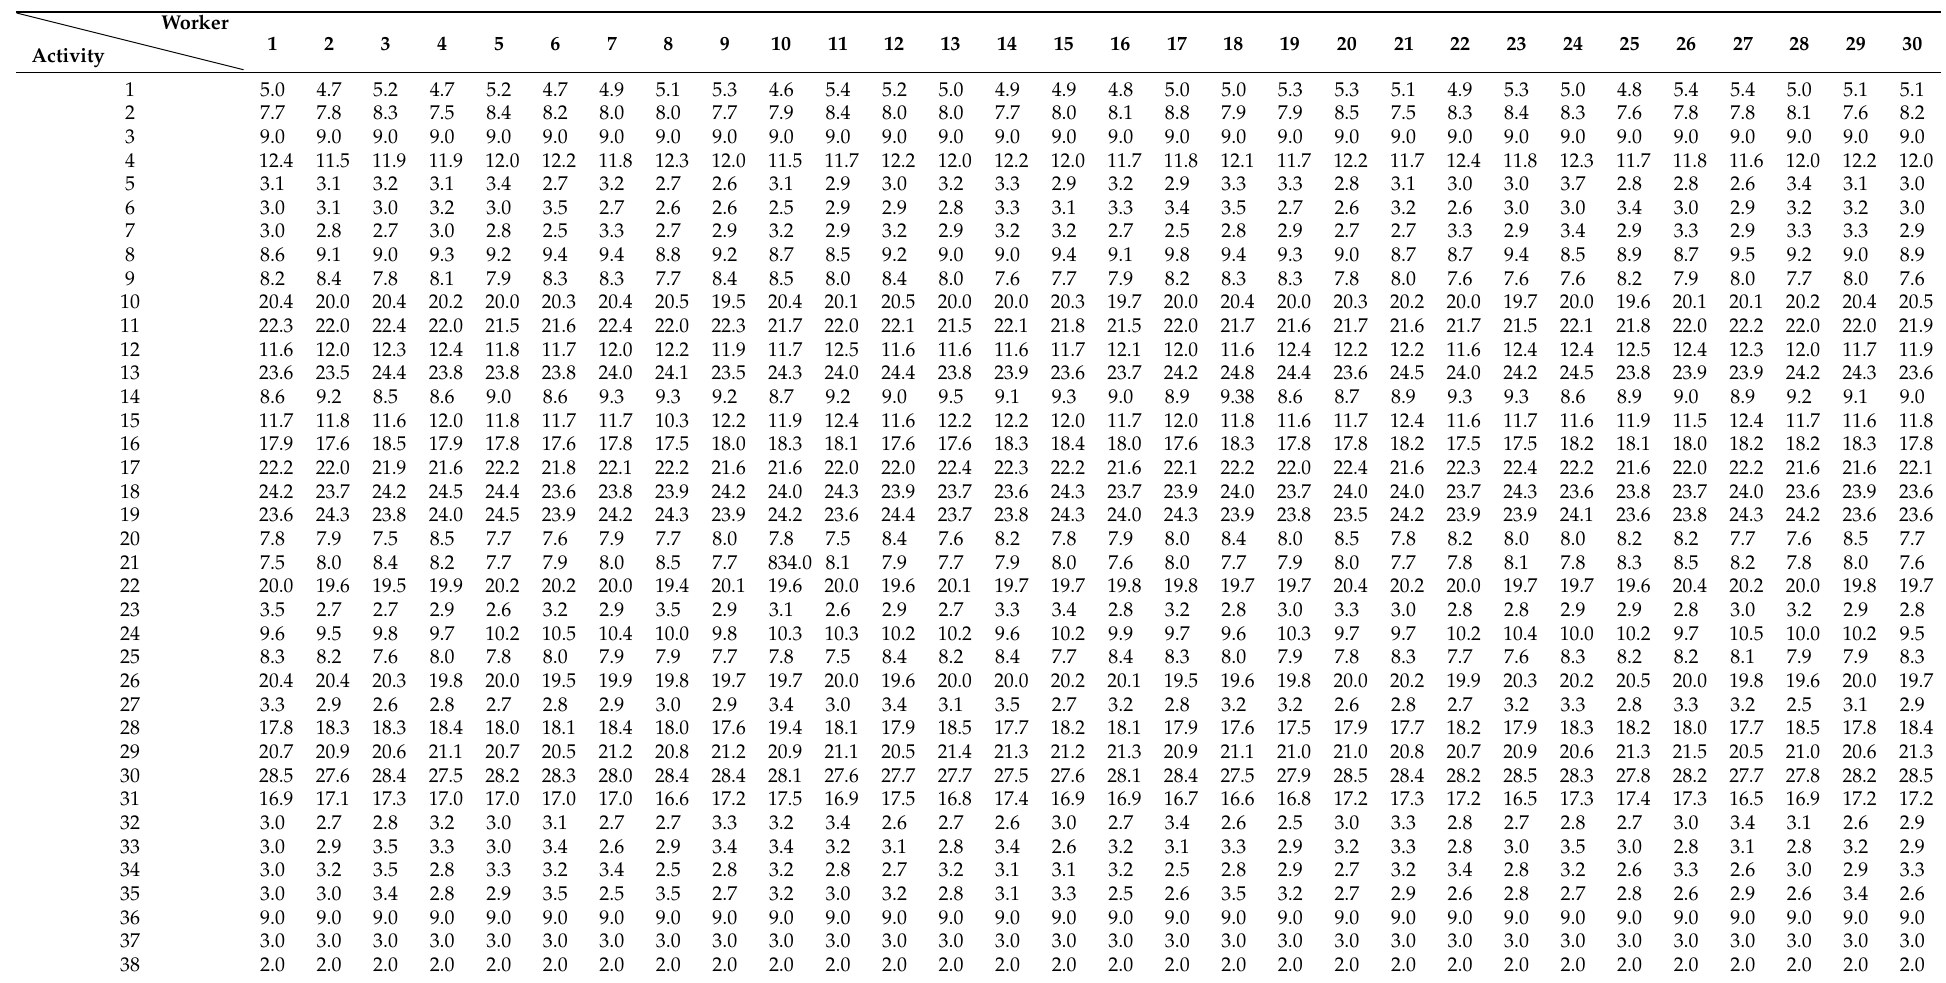
Table 3. Original activity-duration